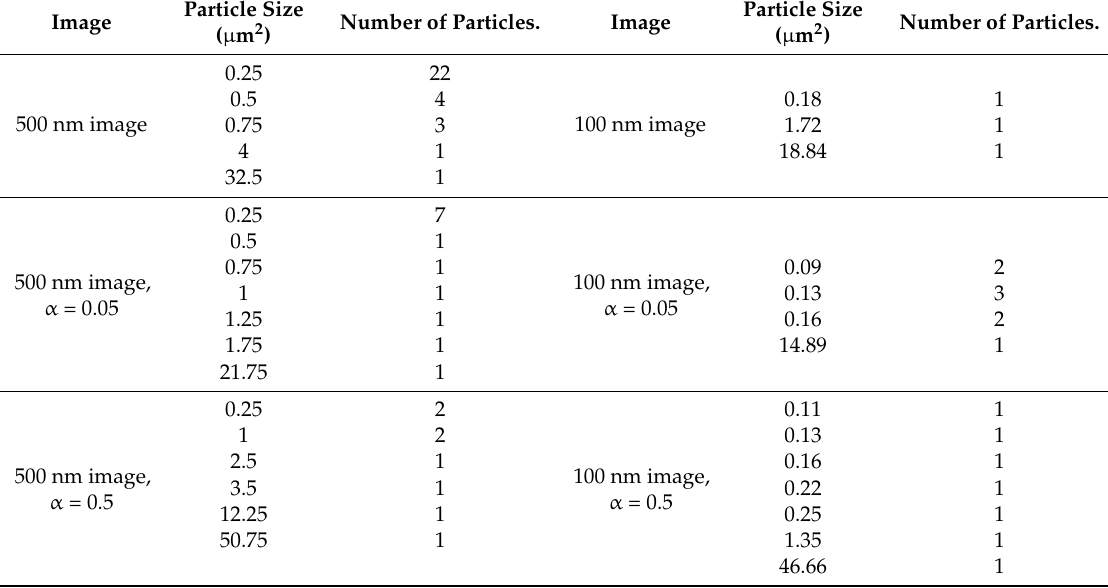
Table 3. Summary of the number of particle agglomerates ( ě 0.09 µ m 2 ) in the threshold images in Figure